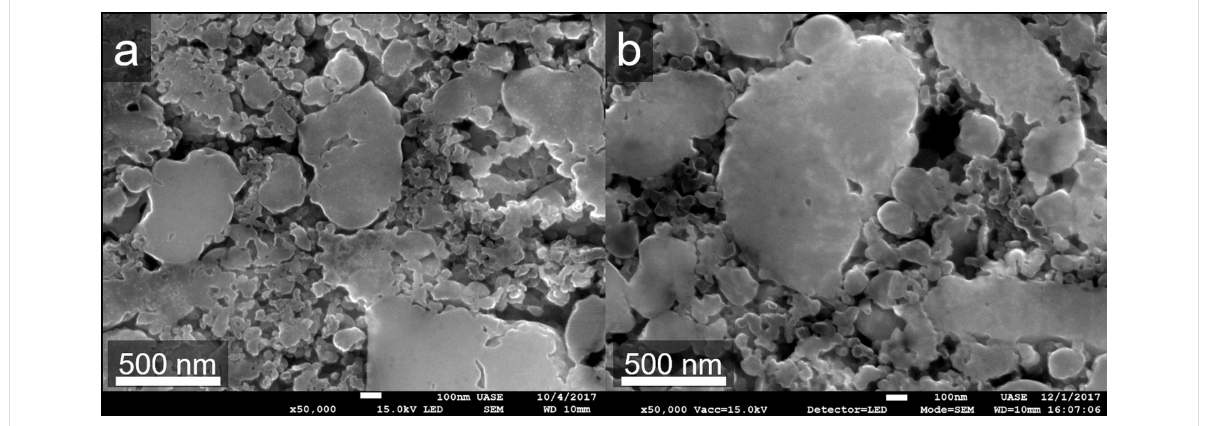
Figure 1: SEM cross-section view of the fresh (a) and aged (b) cathode.